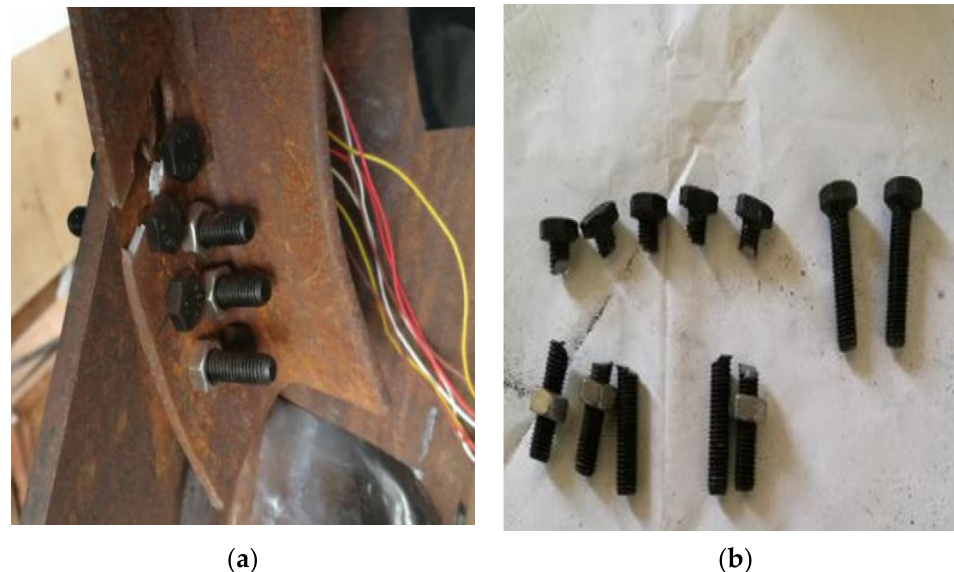
Figure 7. ( a ) Connecting angle steel after unloading of SLSPJ; ( b ) Connecting bolts after unloading of SLSPJ.